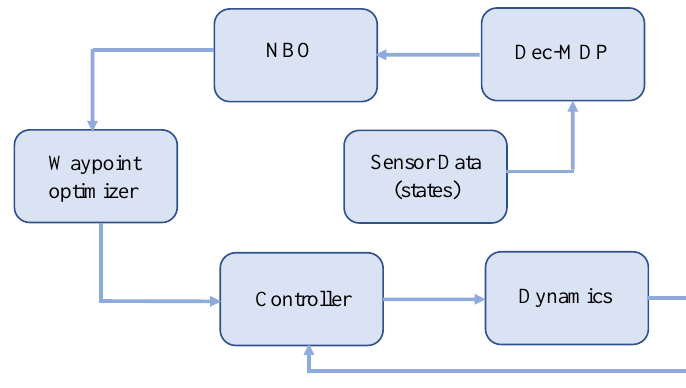
Figure 1. UAV formation shape control